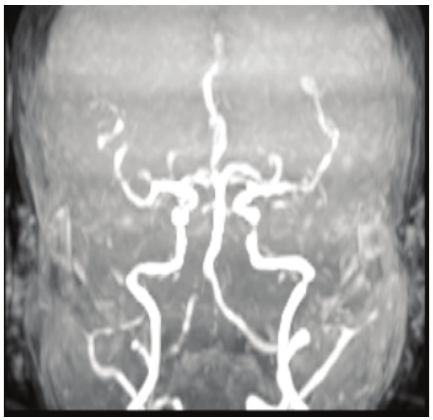
Figure 2: Stenotic segment determined in the right vertebral artery distal according to the MR